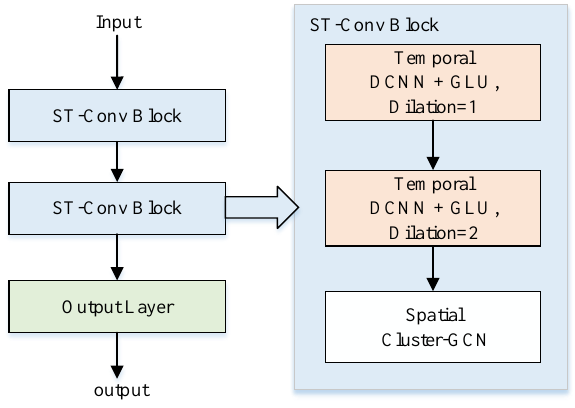
Figure 1 . The framework of